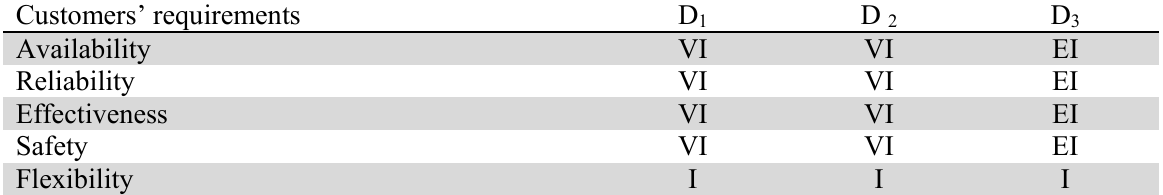
The experts’ linguistic expressions for the customers’ requirements importance Customers’ requirements